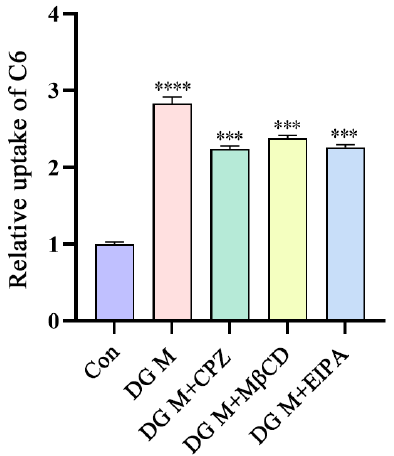
Figure 11. Relative uptake of C6 determined by flow cytometry. The fluorescence intensity of the Con group was used as the standard for relative quantification. **** p < 0.001 compared with the Con group, *** p < 0.05 compared with the DG M group.